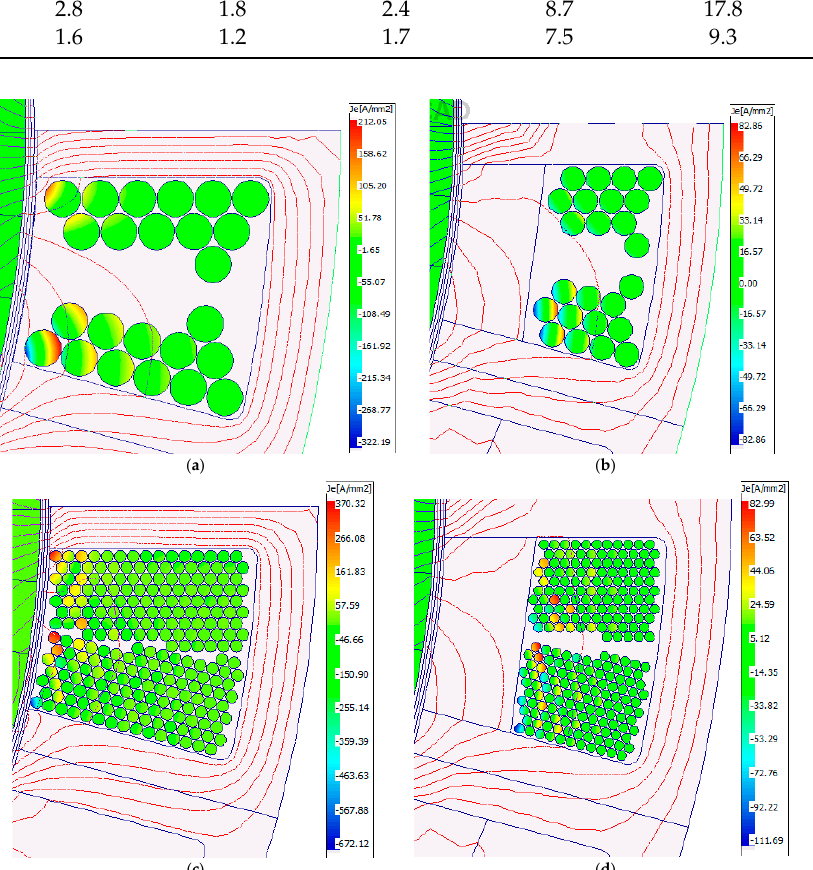
Figure 9. The S24 − P20 stranding results: ( a ) 1 strand, 100% depth, 48.5 kW, ( b ) 1 strand, 60% depth, 4.6 kW, ( c ) 10 strand, 100% depth, 186.2 kW, and ( d ) 10 strand, 60% depth, 9.7 kW.